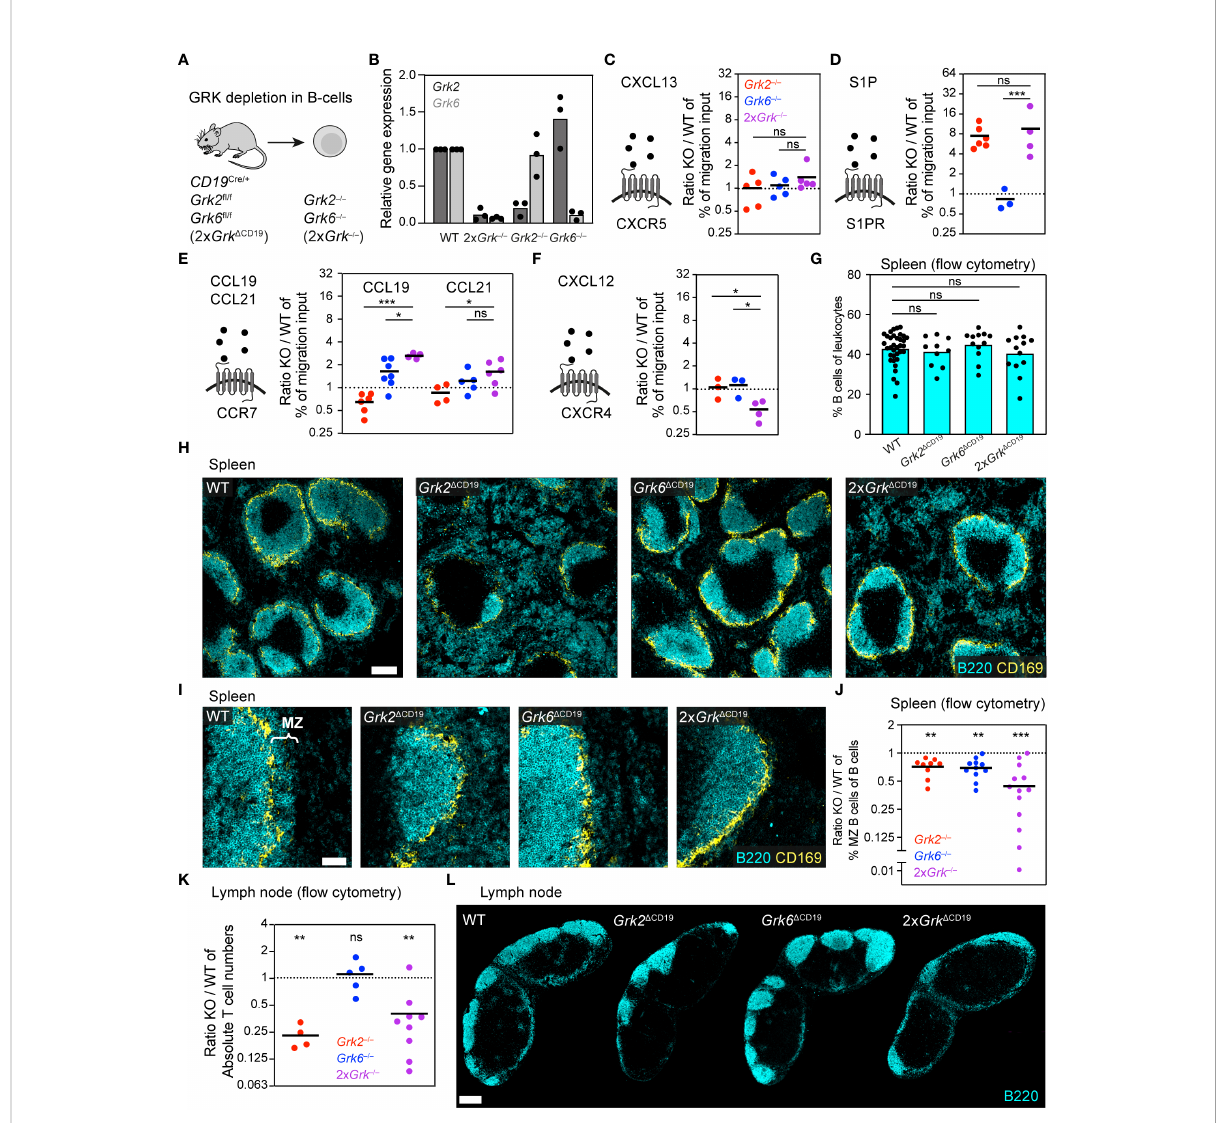
FIGURE 3 Combined depletion of GRK2 and GRK6 in B cells has opposite effects to those in T cells. (A) Scheme of the mouse model used for the generation of B cells with individual and combinatorial GRK depletion. (B) Con fi rmation of knockout ef fi ciency by quantitative RT-PCR. Relative gene expression of splenic Grk -de fi cient B cells, normalized to WT. n = 3 biological replicates performed as independent experiments with N = 3 technical replicates each. Bars display the mean. (C-F) Schemes of chemoattractants and their corresponding GPCRs. Transwell migration of splenic B cells toward 0.5 µg/ml CXCL13 (C) , 100 nM S1P (D) , 1 µg/ml CCL19 and 0.1 µg/ml CCL21 (E) , 0.5 µg/ml CXCL12 (F) . Displayed are ratios of Grk -knockout (KO) versus WT. n = 3-7 biological replicates performed as independent experiments with N = 2 technical replicates each. Bars display the mean. *** P <0.001, ** P <0.01, * P <0.05, ns nonsigni fi cant, post hoc after ANOVA. (G) Frequency of B cells in spleens compared to all leukocytes, measured by fl ow cytometry. n = 10-13 mice per KO. Bars display the mean. ns nonsigni fi cant, post hoc after ANOVA. (H) Positioning of WT and Grk -de fi cient B cells in homeostatic spleens. B cells were detected with immunostaining against B220 (cyan). Marginal zone macrophages (CD169, yellow) are displayed for orientation. Scale bar: 200 µm. (I) Zoom-in images of the splenic sections displayed in (H) , focusing on the marginal zone (MZ). Scale bar: 50 µm. (J) Frequency of splenic marginal zone B cells compared to all B cells, measured by fl ow cytometry. Displayed are ratios of KO versus WT. n = 9-13 mice per genotype. Bars display the mean. *** P <0.001, ** P <0.01, one sample t test. (K) Absolute numbers of B cells in inguinal lymph nodes measured by fl ow cytometry, displayed are ratios of KO vs. WT. n = 4-9 mice per KO. Bars display the mean. ** P <0.01, ns nonsigni fi cant, one sample t test. (L) Positioning of WT and Grk -de fi cient B cells in homeostatic lymph nodes. B cells were detected with immunostaining against B220 (cyan). Scale bar: 300